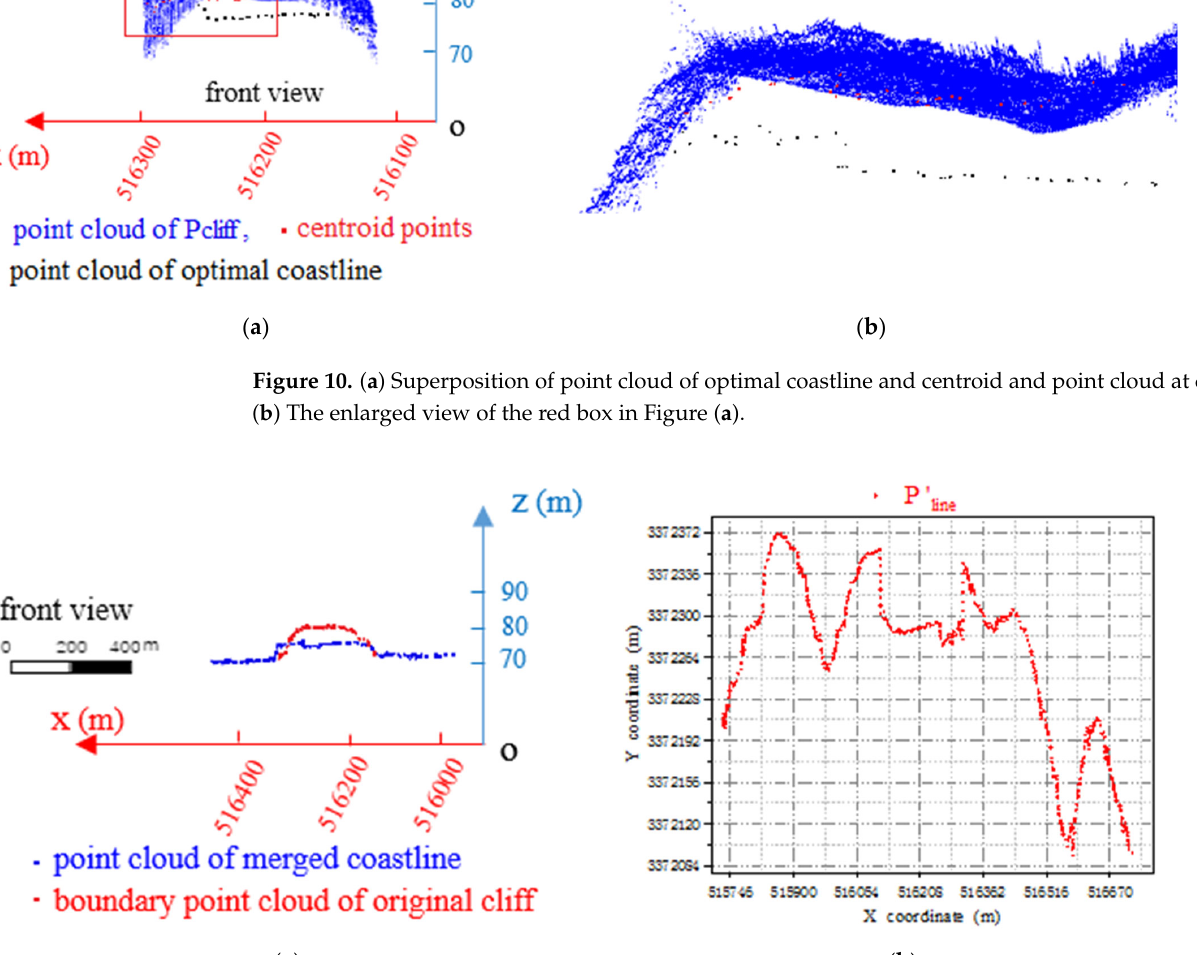
Figure 11. ( a ) Superposition of point cloud of coastline after fusion and original boundary point cloud; ( b ) The completion of point cloud of coastline after fusion.